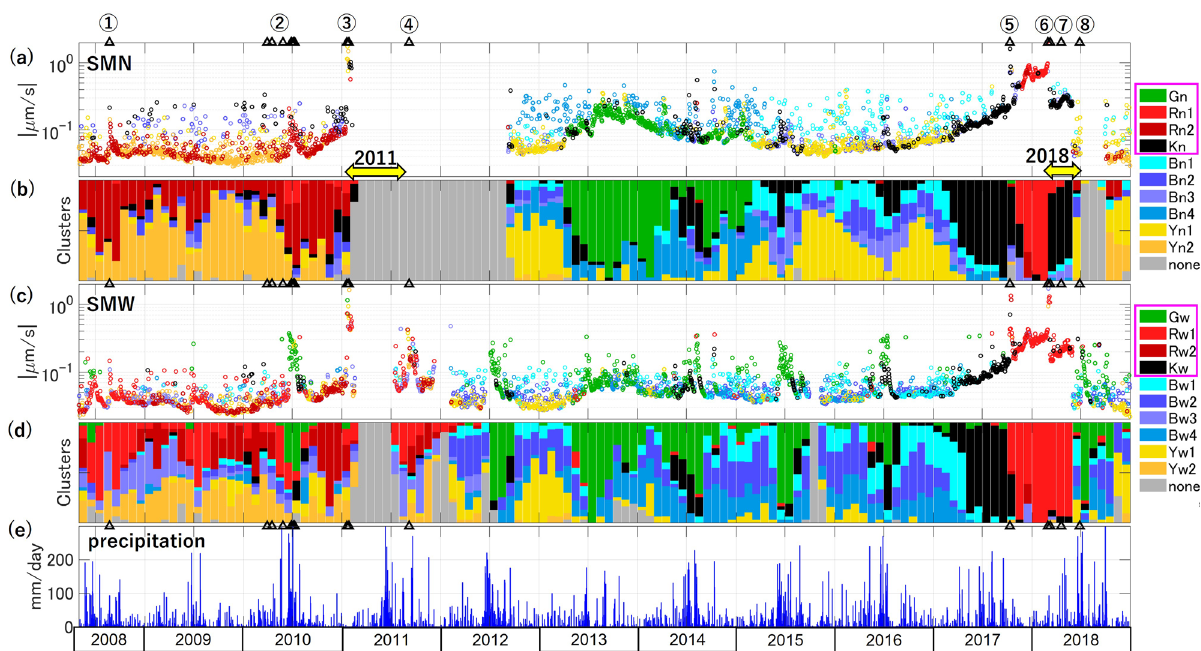
Figure 4. The clustering analysis results at SMN (ab) and at SMW (cd) for the daily SBL spectra, P SBL , shown in Fig. 2d and e, respectively. ( a , c ) The smaller value of the SBLs in the night window and the next morning window is selected as the SBL of each day and is plotted with a circle of the color corresponding to its spectral cluster as in the legend, ( b , d ) The monthly fractions of days belonging to each cluster are shown by bars of the same color. The clusters of current interest are enclosed by the magenta rectangles in the legends. The gray clusters represent data with problems. ( e ) The daily precipitation data recorded near KVO station in Fig. 1a. The black triangles and circled numbers are the same as in Fig.